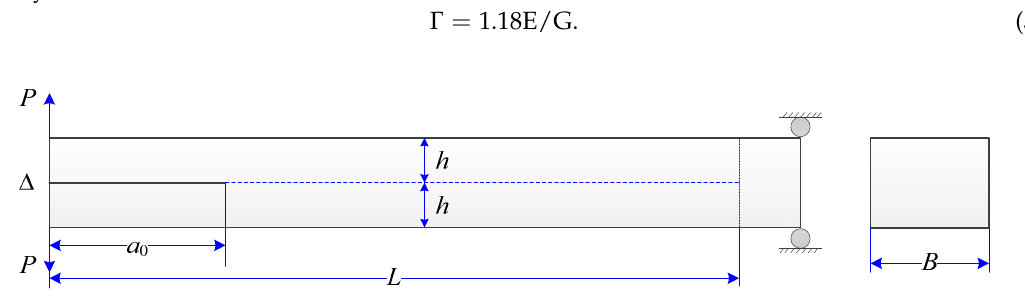
Figure 8. Configuration, loading, and boundary condition of a double cantilever beam (DCB) model.